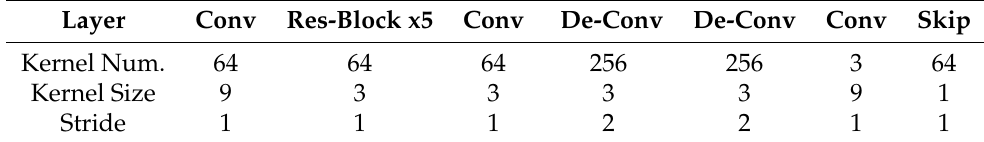
Table 1. Architecture of the generator in CMTGAN.